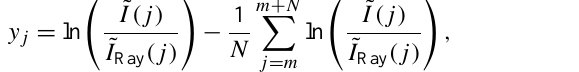
course of 12h due to orbit. Here an example of an ascending track